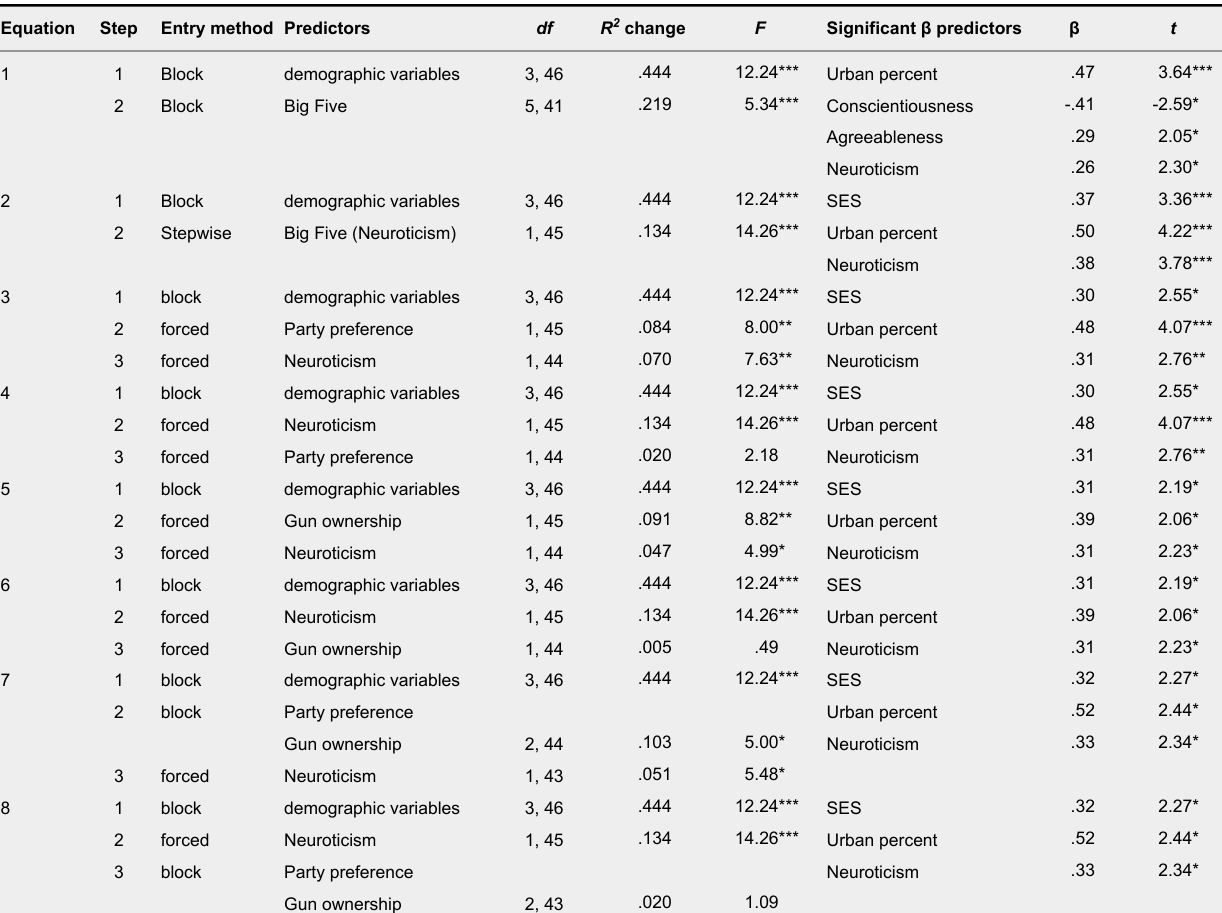
Hierarchical Multiple Regression Equations Computed With State Gun Laws as the Dependent